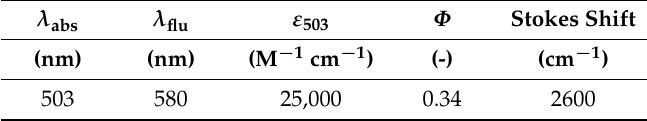
Table 1. Photophysical properties of BODIPY 1 in acetonitrile.